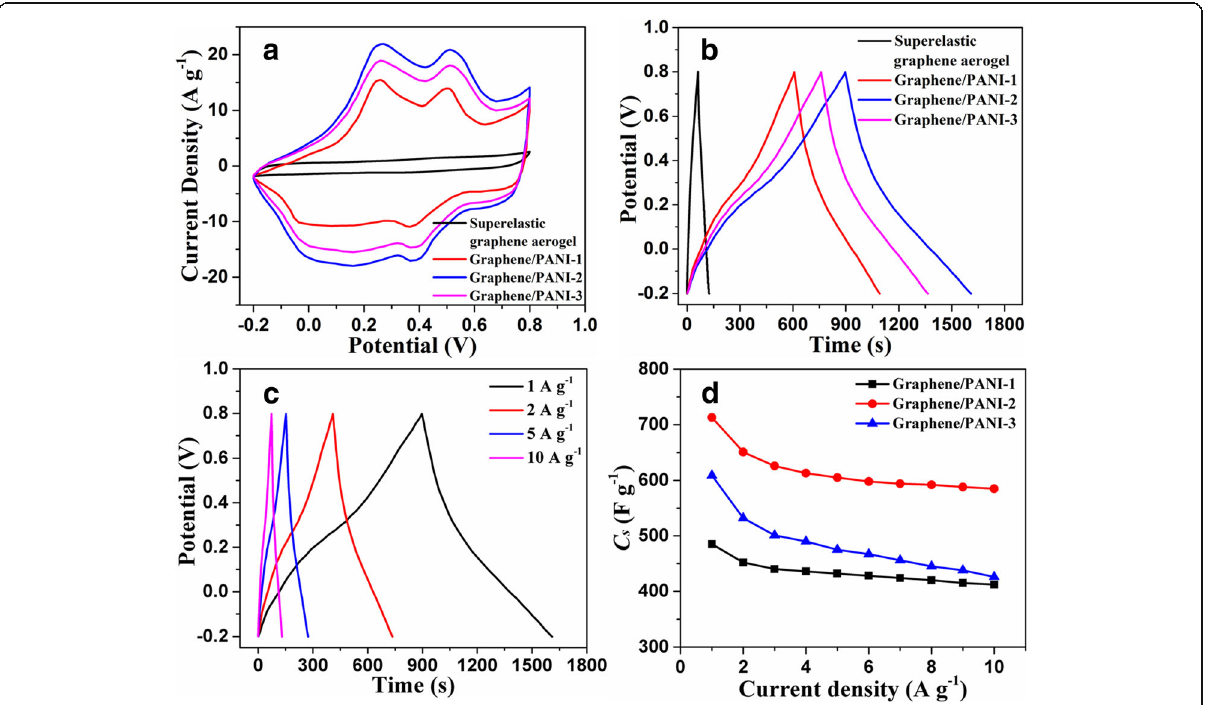
Fig. 6 a CV curves and b GCD curves of superelastic graphene aerogel and graphene/PANI-1 ~ 3 aerogels, scan rate: 20 mV s − 1 , current density: